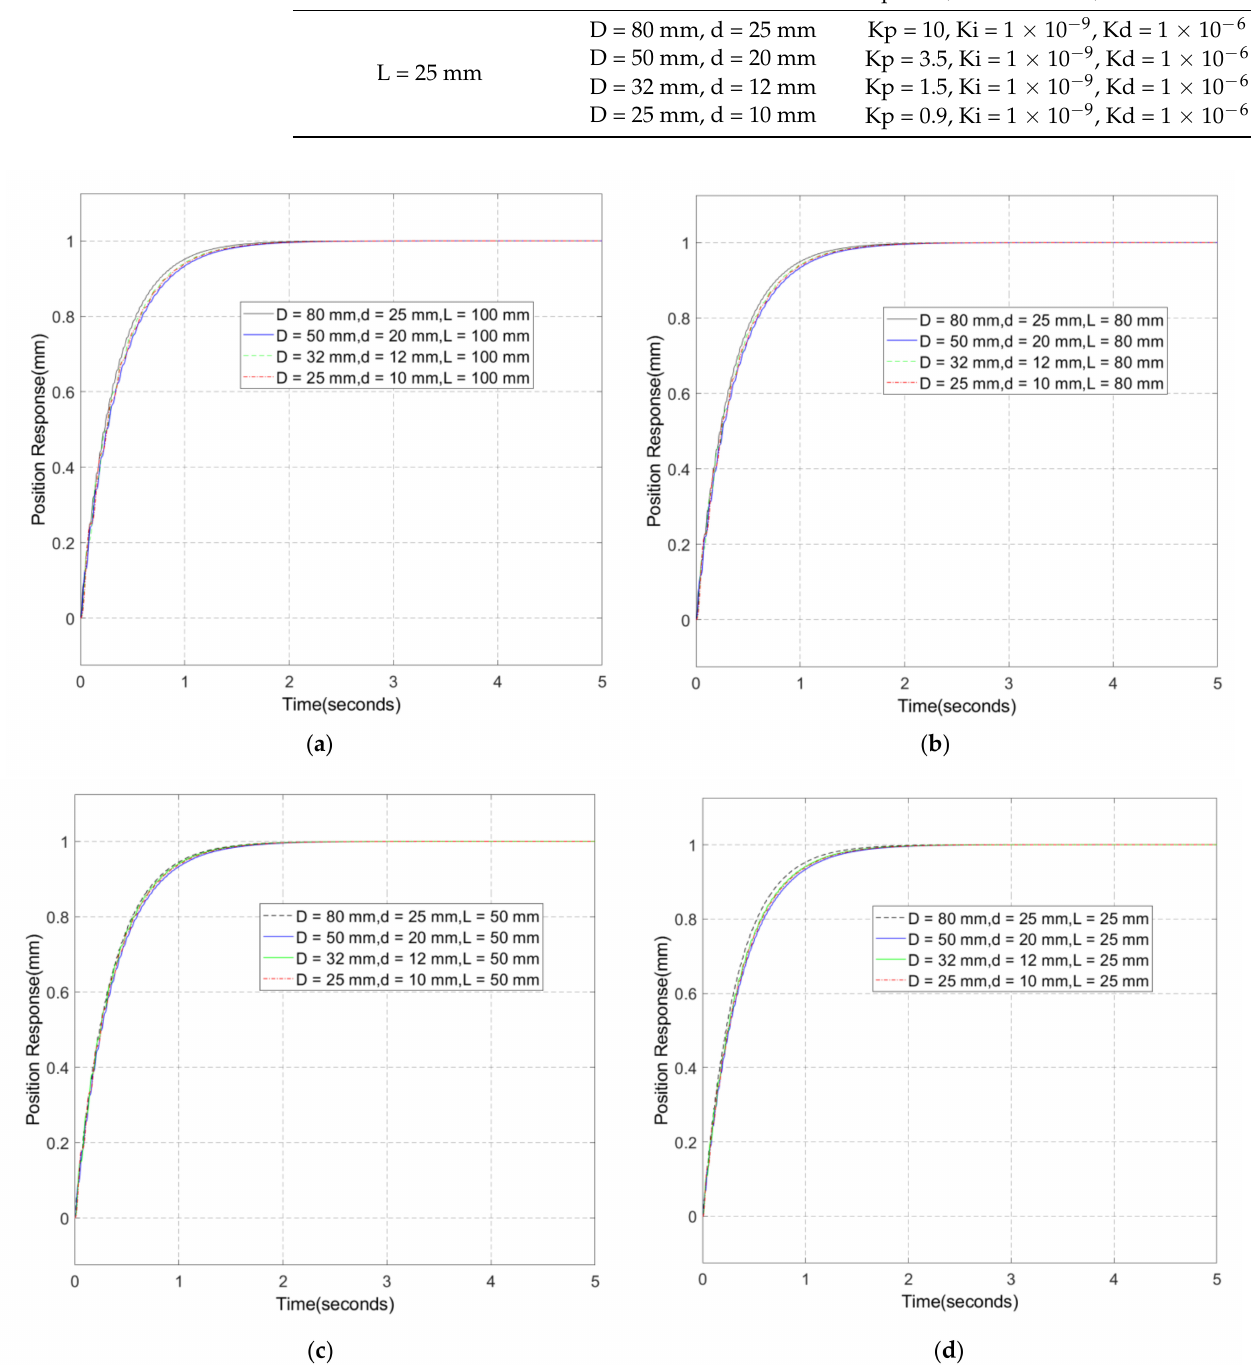
Figure 14. Response curves of different cylinder bore positions. ( a ) L = 100 mm; ( b ) L = 80 mm; ( c ) L = 50 mm; ( d ) L = 25